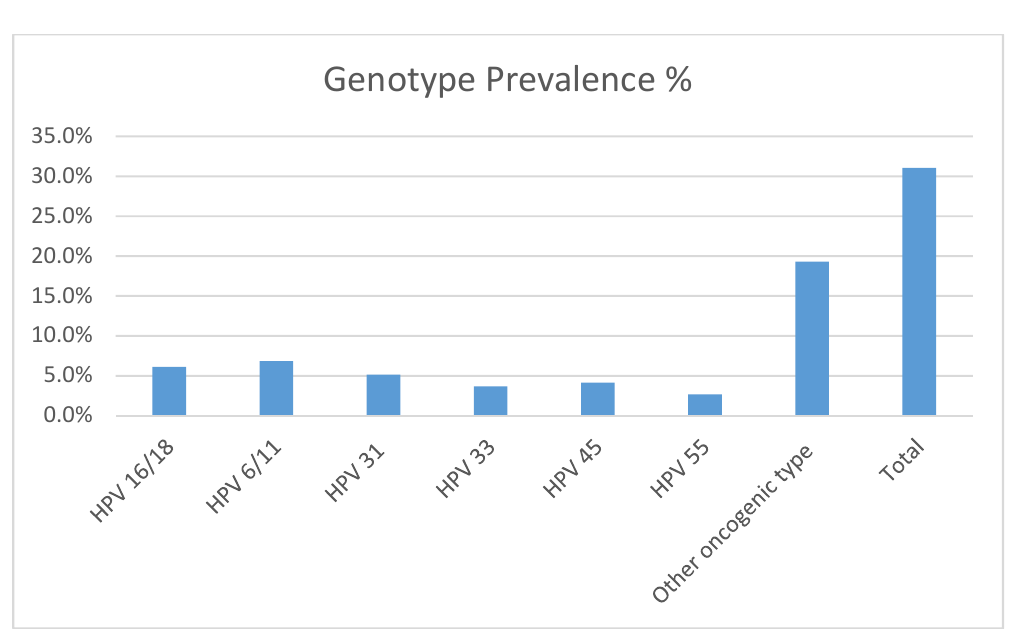
Figure 2. HPV prevalence 6/11 and 16/18, and other high ‐ risk HPV according to vaccination status. 3.4. Relationship between HPV Infection and Sociodemographic Table 2 reports the association between country of origin and HPV positivity. Non ‐ Swiss women had higher odds ratios of being HPV ‐ positive than the participants who came from Switzerland, (Adjusted OR (aOR) = 4.4 confidence interval (CI) 95% [1.3–7.6] and aOR = 3.8 CI 95% [2.4–4.1], respectively). There was also a very strong association between sexual activity and HPV positivity, as young women who reported having more than five different sexual partners throughout their sex life had higher odds of being infected with HPV when compared with women who had only one sexual partner aOR = 7.8 CI 95% [2.4–12.2]. Female students who sometimes used condoms were more likely to be HPV ‐ infected than those who reported always using condoms aOR 7.5 CI 95% [6.3– 8.7], this relationship was also found for those who never used a condom aOR 6.6 CI 95 % [4.8–8.2].